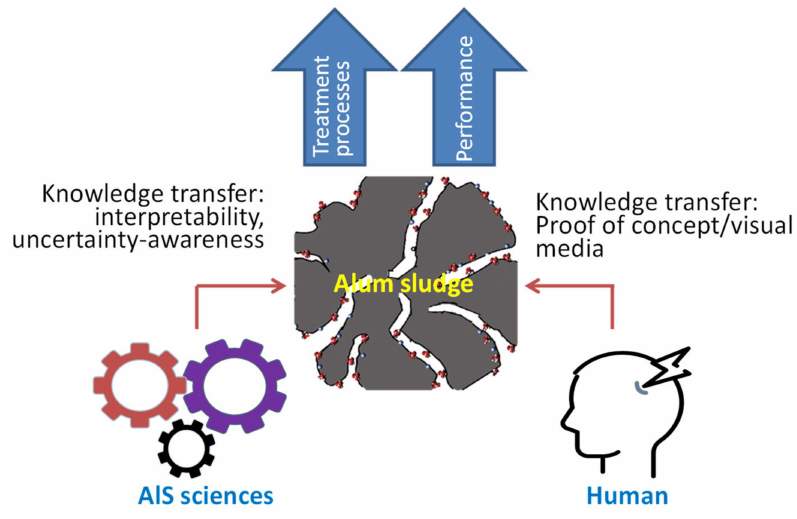
Figure 5. Conceptual patterns of knowledge transfer: from science to engineering of AlS